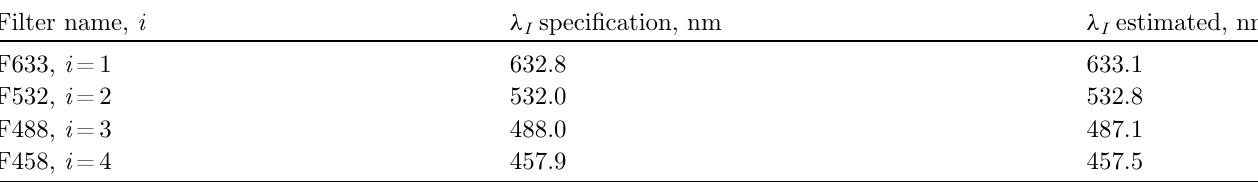
Table 5. Estimated centroid wavelengths of all the fi lters of the